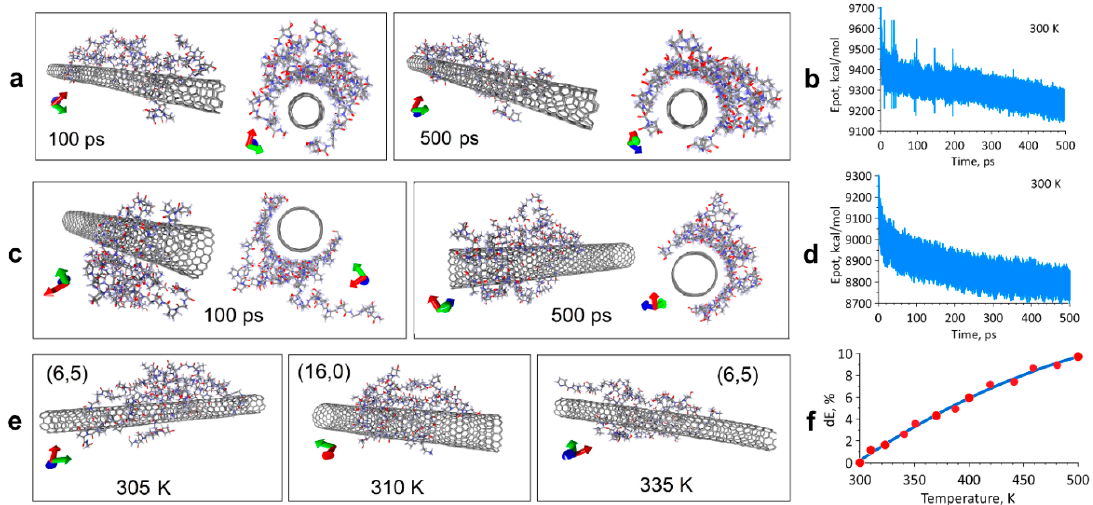
Figure 1. Molecular-dynamic empirical study of the formation process of the equilibrium configuration of the SWCNT / collagen complex: ( a ) Complex with SWCNTs (6,5) at 300 K; ( b ) Potential energy graph for the SWCNTs (6,5); ( c ) Complex with SWCNTs (16,0) at 300 K; ( d ) Potential energy graph for the SWCNTs (16,0); ( e ) Structures of complexes at various temperatures exceeding 300 K; ( f ) The change in the relative value of potential energy with increasing temperature.